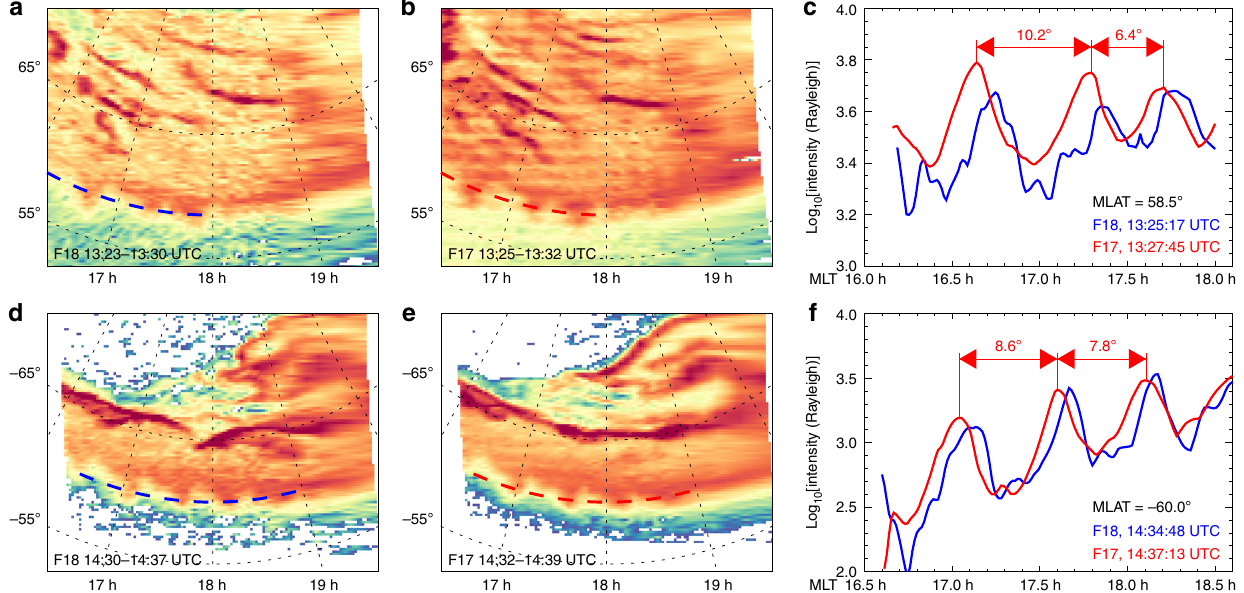
Fig. 3 Determination of the phase speed and azimuthal wavelength of SA. a Auroral image obtained by the DMSP F18 satellite for 13:23 – 13:30 UTC in the NH with the SA captured at 13:25:17 UTC. b Auroral image obtained by the DMSP F17 satellite between 13:25 – 13:32 UTC in the NH with the SA captured at 13:27:45 UTC. c Emission intensity variations of the SA at the AACGM latitude of 58.5° as indicated by the blue dashed line in ( a ) and red dashed line in ( b ). d Auroral image obtained by the DMSP F18 satellite between 14:30 and 14:37 UTC in the SH with the SA captured at 14:34:48 UTC. e Auroral image obtained by the DMSP F17 satellite between 14:32 and 14:39 UTC in the SH with the SA captured at 14:37:13 UTC. f Emission intensity variations of the SA at the AACGM latitude of − 60° as indicated by the blue dashed line in ( d ) and red dashed line in ( e